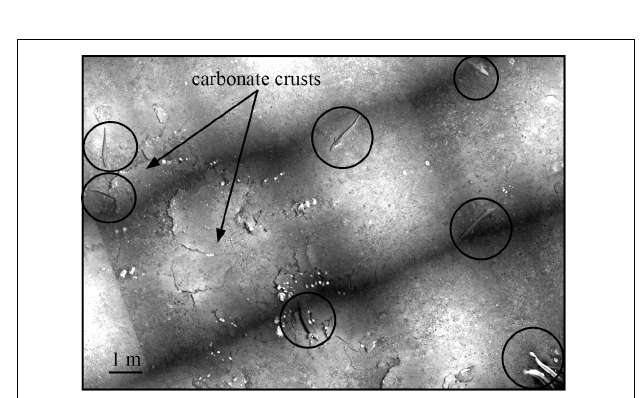
FIGURE 9 | TFish photo mosaic showing carbonate crusts and ling cod up to 1.4 m (in circles).